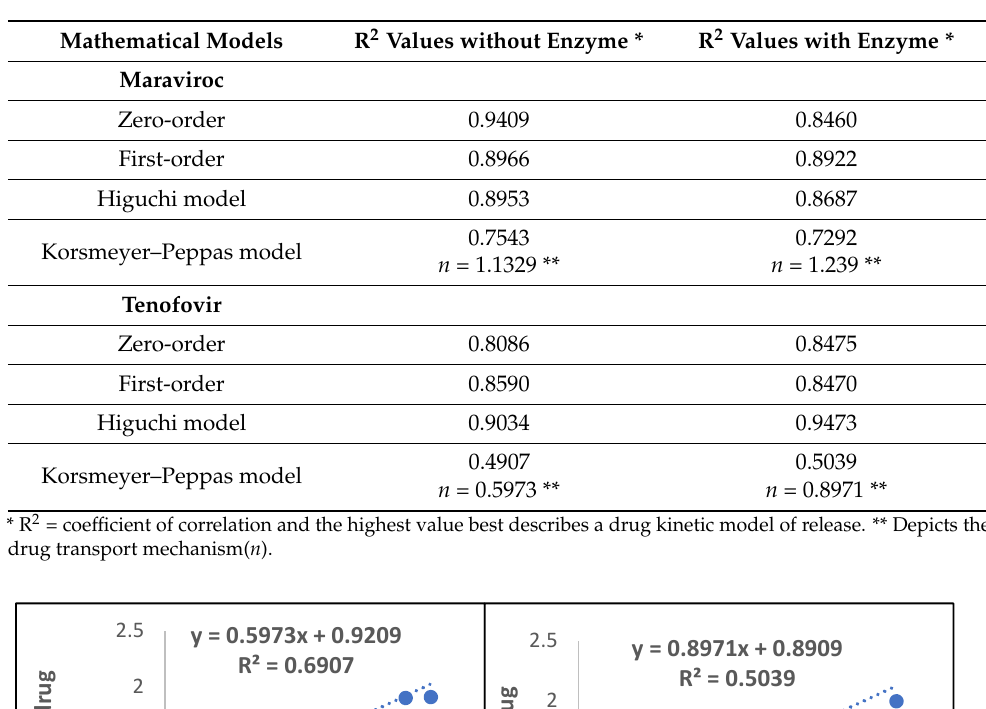
Figure 1: (A) Zero-order kinetic release of maraviroc from microspheres. (B) First-order kinetic re- Figure 1. ( A ) Zero-order kinetic release of maraviroc from microspheres. ( B ) First-order kinetic lease of maraviroc from microspheres facilitated with enzymes. release of maraviroc from microspheres facilitated with enzymes. Table 2. Mathematical models for maraviroc and tenofovir release kinetic data.